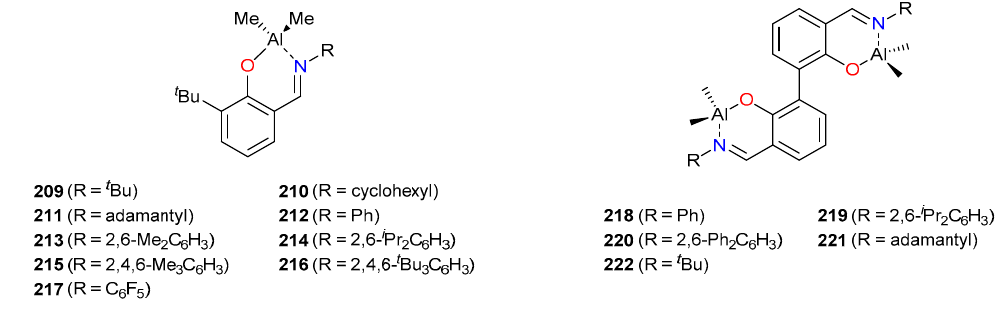
Figure 36. Al-Phenoxy-imine catalysts developed by Namura et al. [112,113].